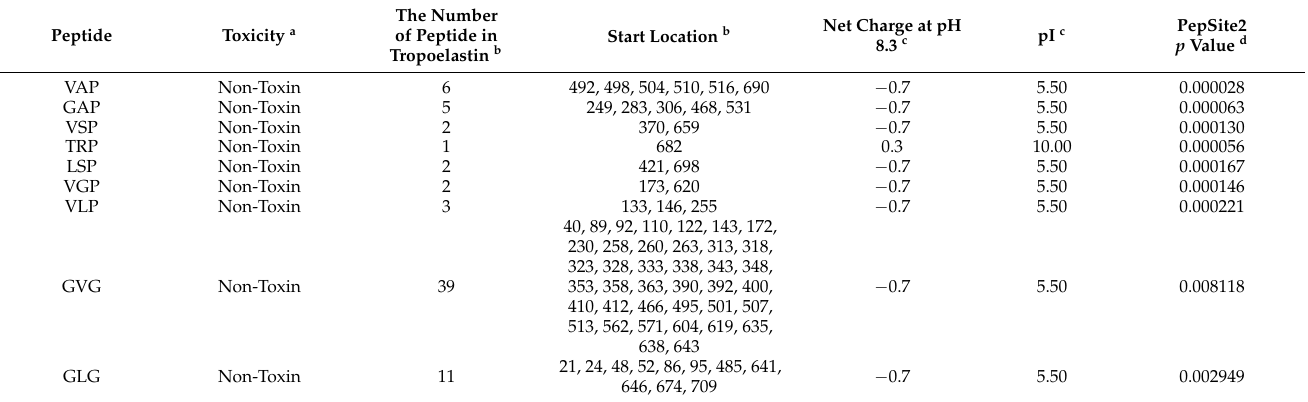
Table 3. Informative data on ACE inhibitory peptides obtained using online